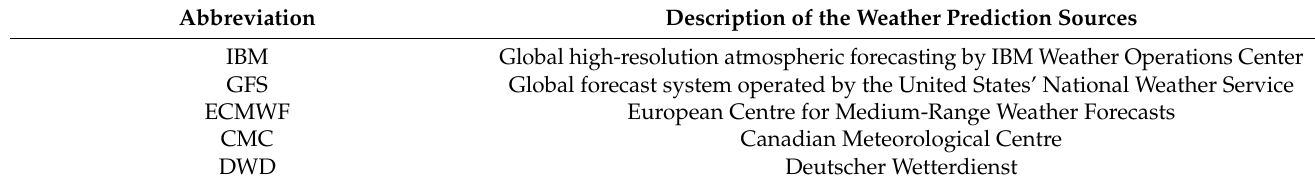
Table 3. Examples of commercial weather prediction